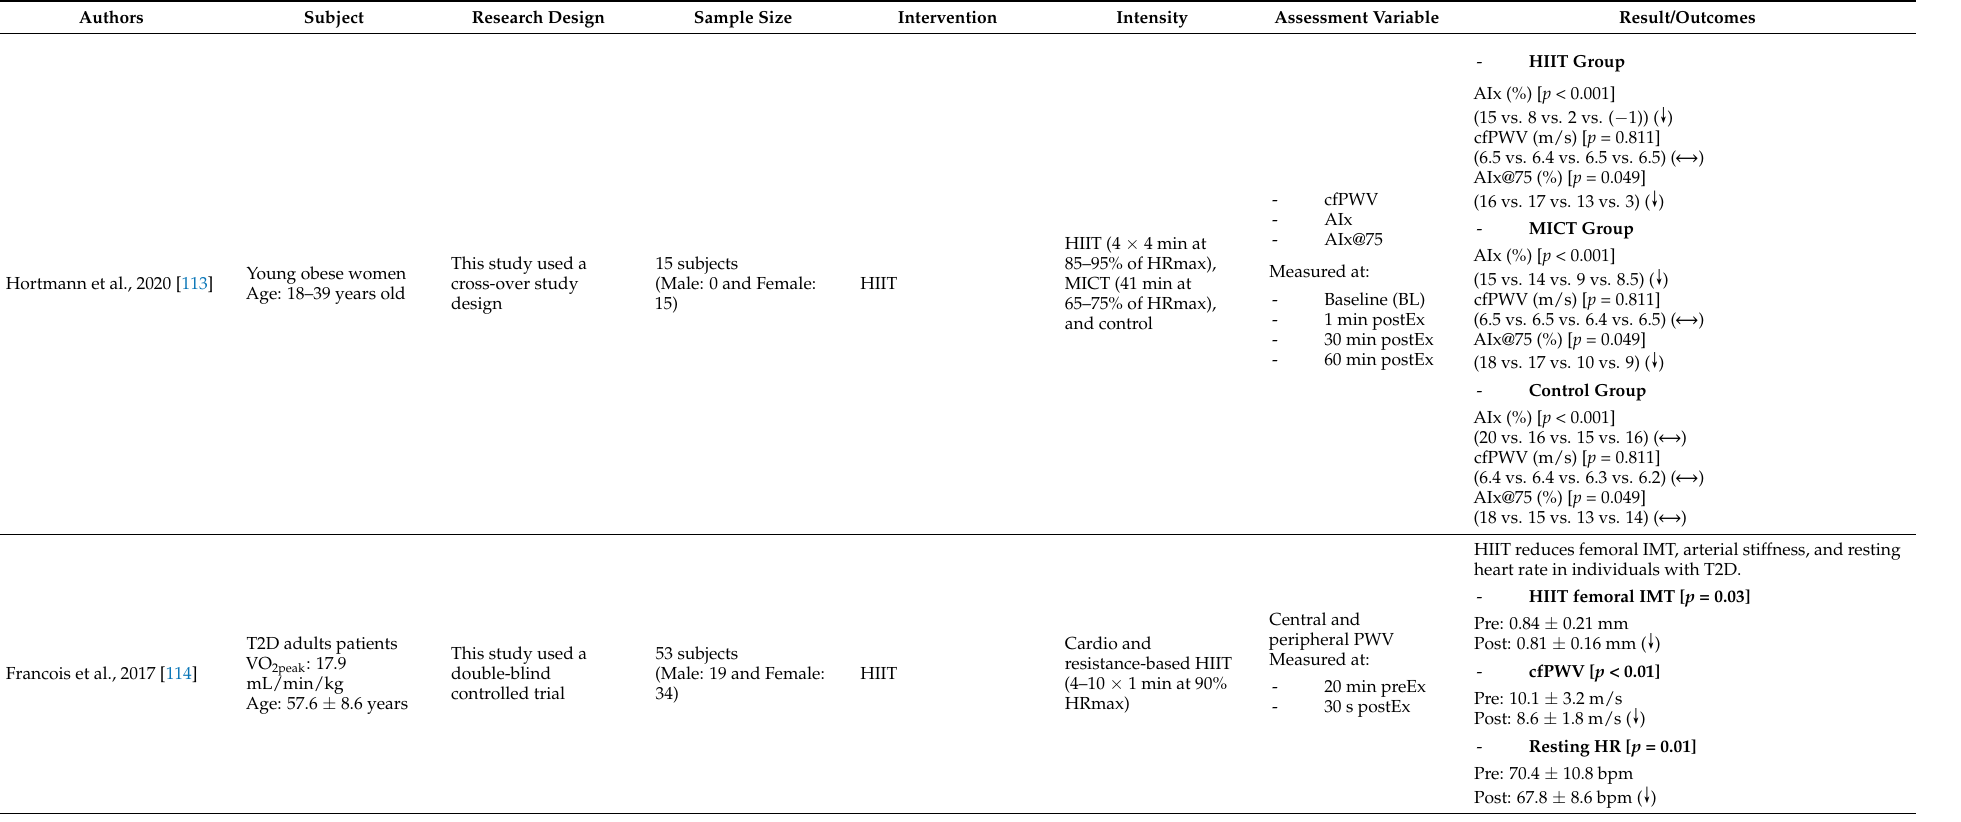
Table 2. Effect of aerobic exercise training on arterial stiffness.